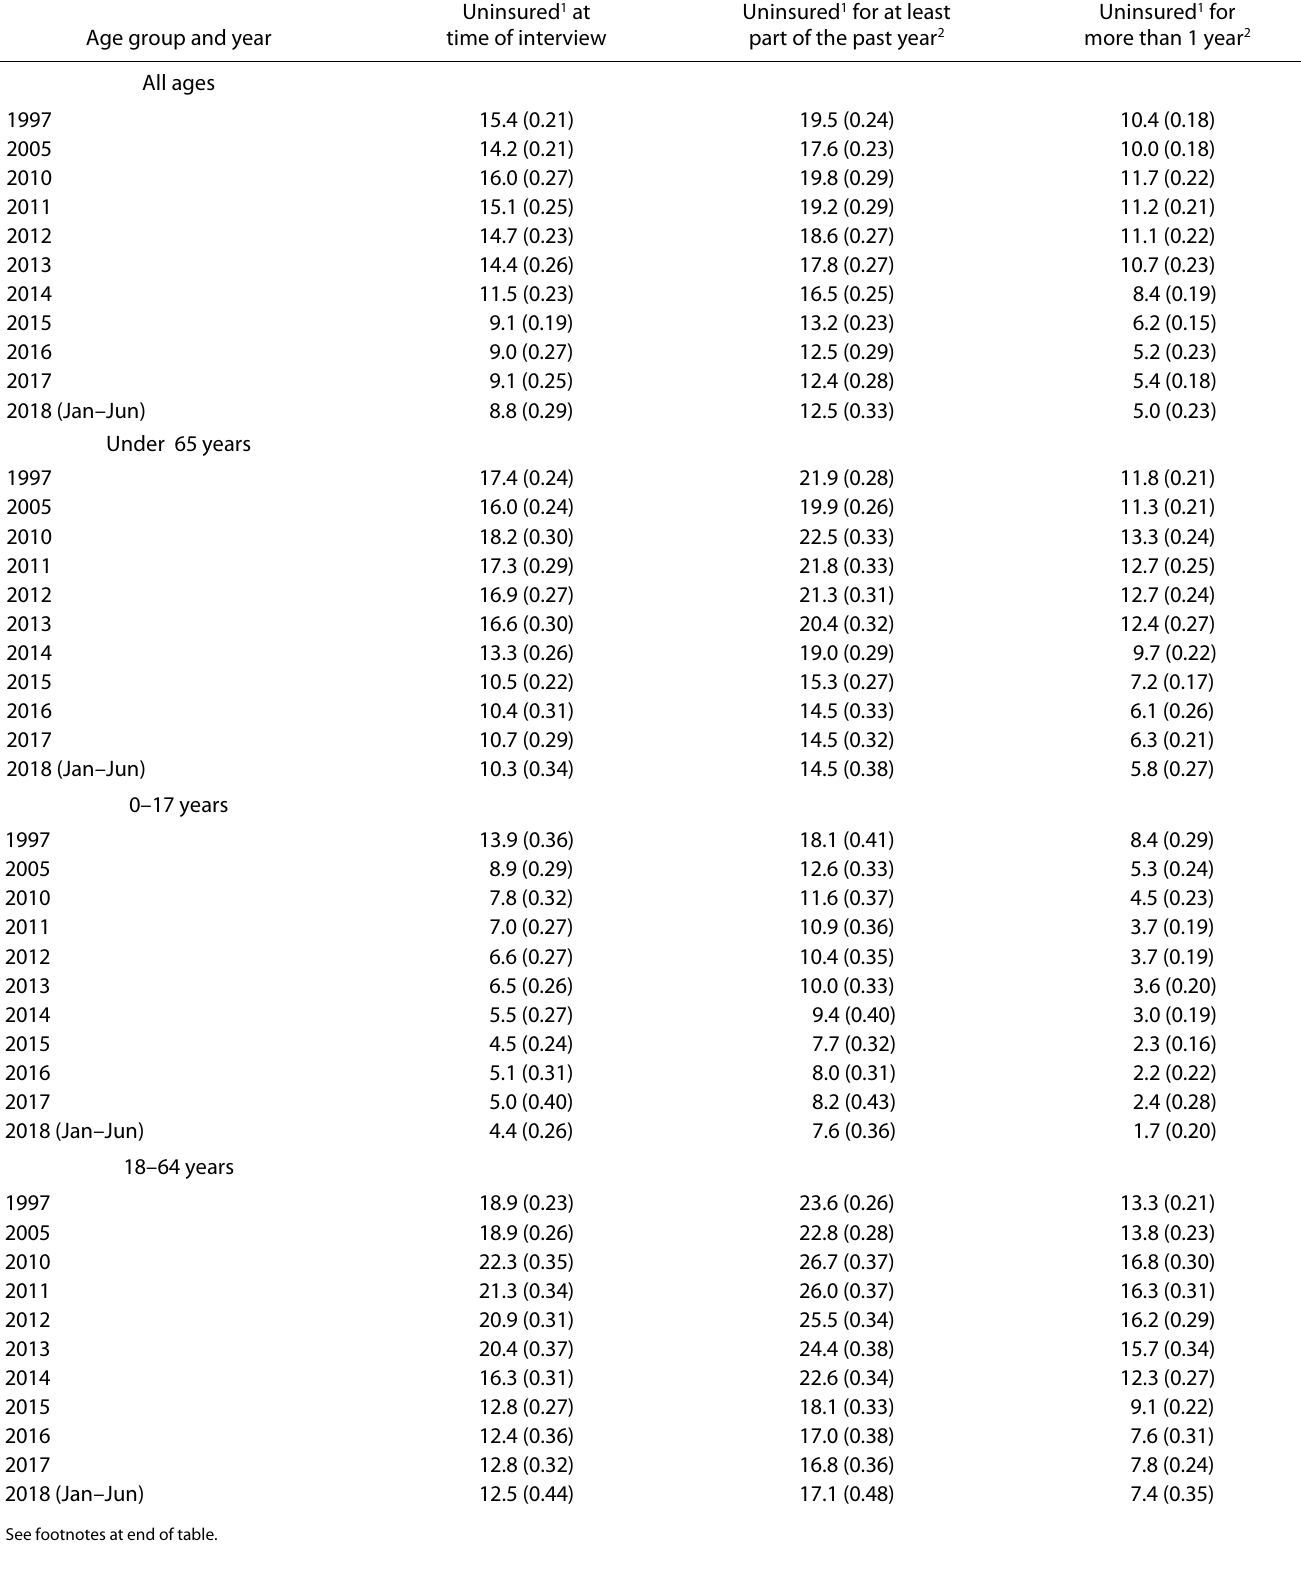
Table I. Percentages (and standard errors) of persons who lacked health insurance coverage at the time of interview, for at least part of the past year, and for more than 1 year, by age group and selected years: United States, 1997–June